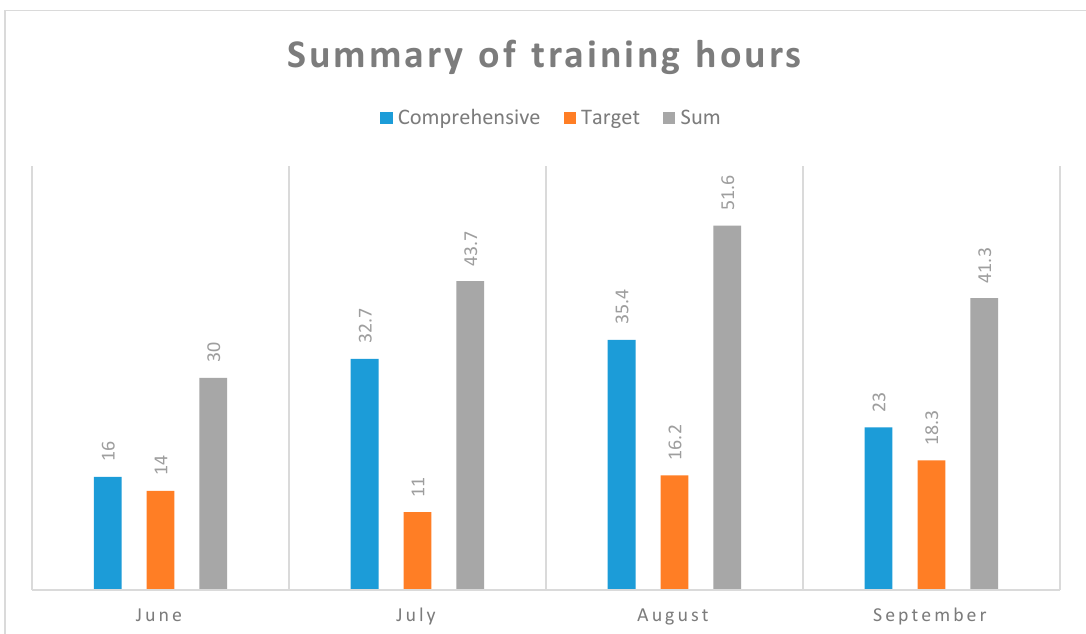
Figure 3. Summary of training hours .